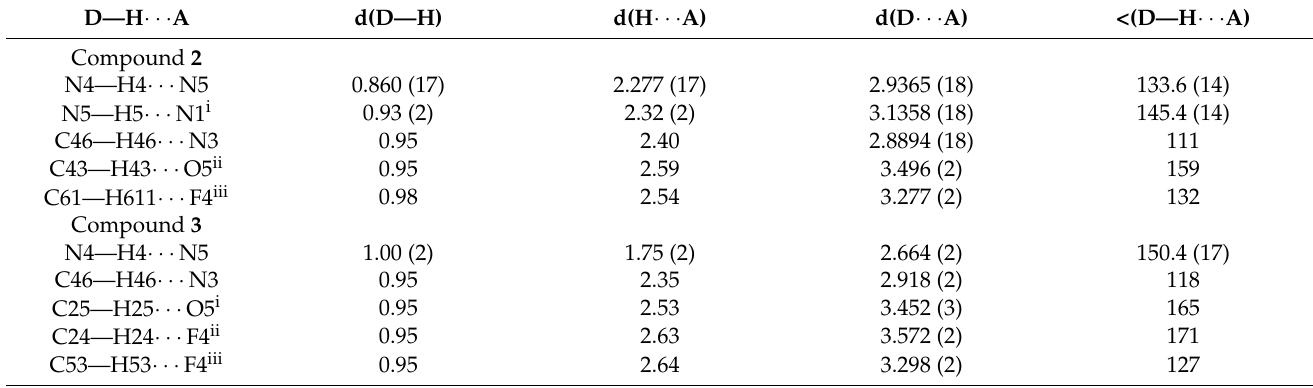
Table 1. Hydrogen bonding geometrical parameters for crystals 2 and 3 (Å, ◦ ).